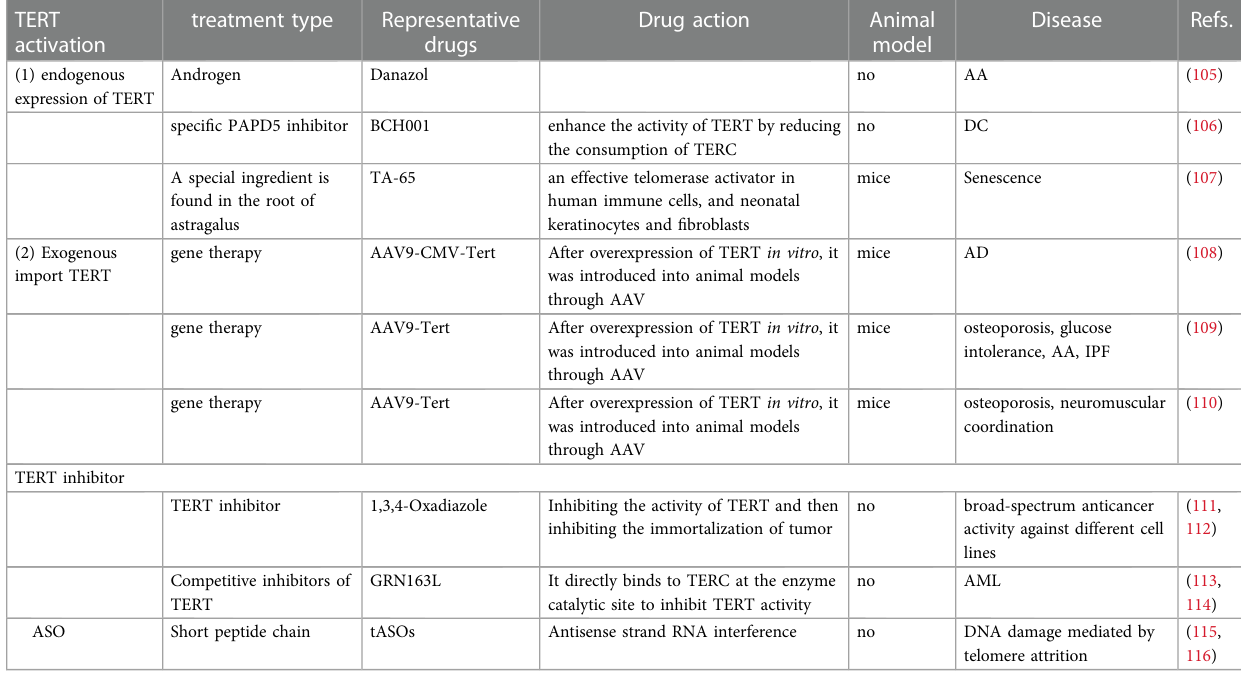
TABLE 2 Prospect of treatment of telomere dysfunction-related diseases.